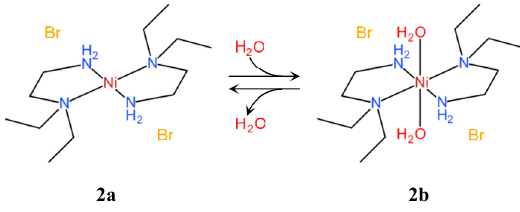
Figure 9. Distances and angles of bonds around Ni(ii) ion of 2a , 2b , and 2c .